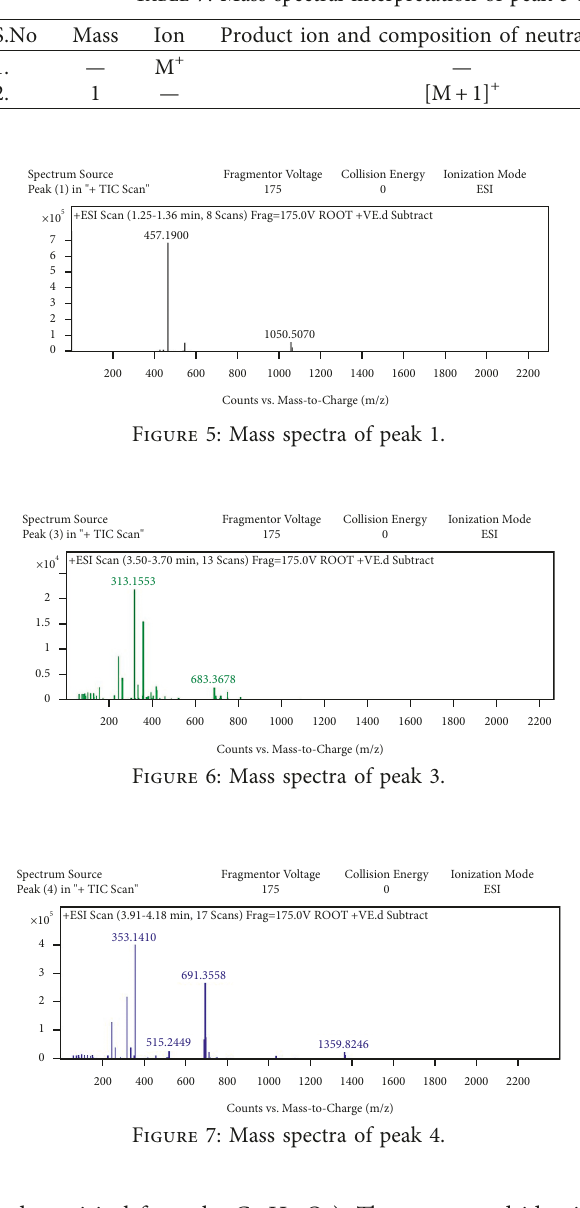
Table 7: Mass spectral interpretation of peak 5 from LC-MS-MS done on A. candolleanus root extract.